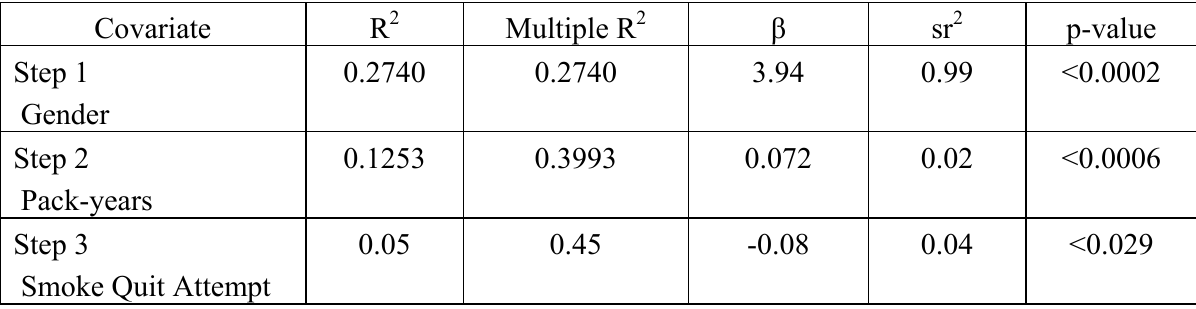
Table 3. Regression Analyses for Hypothesized Prediction: Preparation